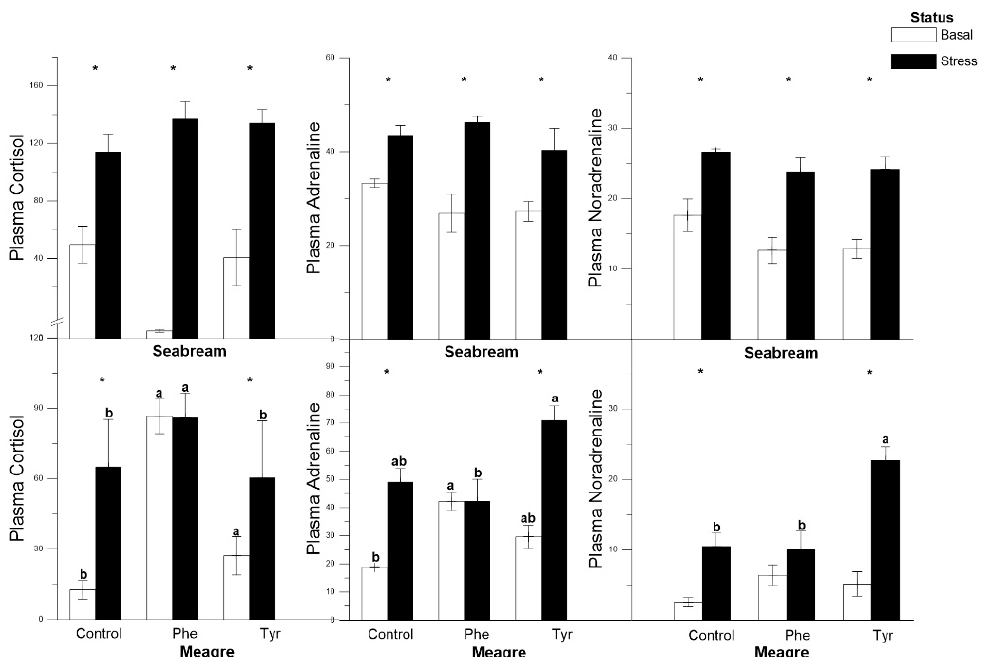
Figure 2. Plasma cortisol, adrenaline and noradrenaline concentrations (ng mL − 1 ) for each treatment (mean ± SE, n = 10). The white and black bars are the basal and stress values, respectively. Asterisks indicate significant differences between the basal and stress conditions. Different letters indicate significant differences among feeding treatments within every condition.